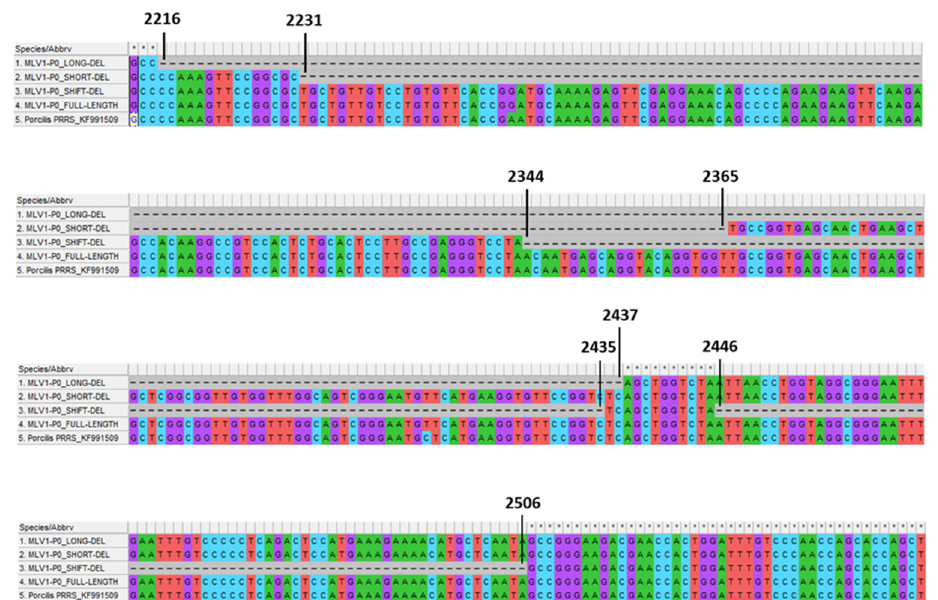
Figure 6. Alignment of the four PRRSV forms (three deletion variants and one full-length sequence) found in both Porcilis ® PRRS batch No. A142DB01 (Trial#1) and batch No. A207CB01 (Trial#2) with the KF991509.2 full-genome sequence of Porcilis ® PRRS DV strain as reference. Alignment targeted nucleotide positions from 2213 to 2545, including the deleted region (position No. starting from the first nt of 5 ′ nontranslated region (5 ′ NTR)).